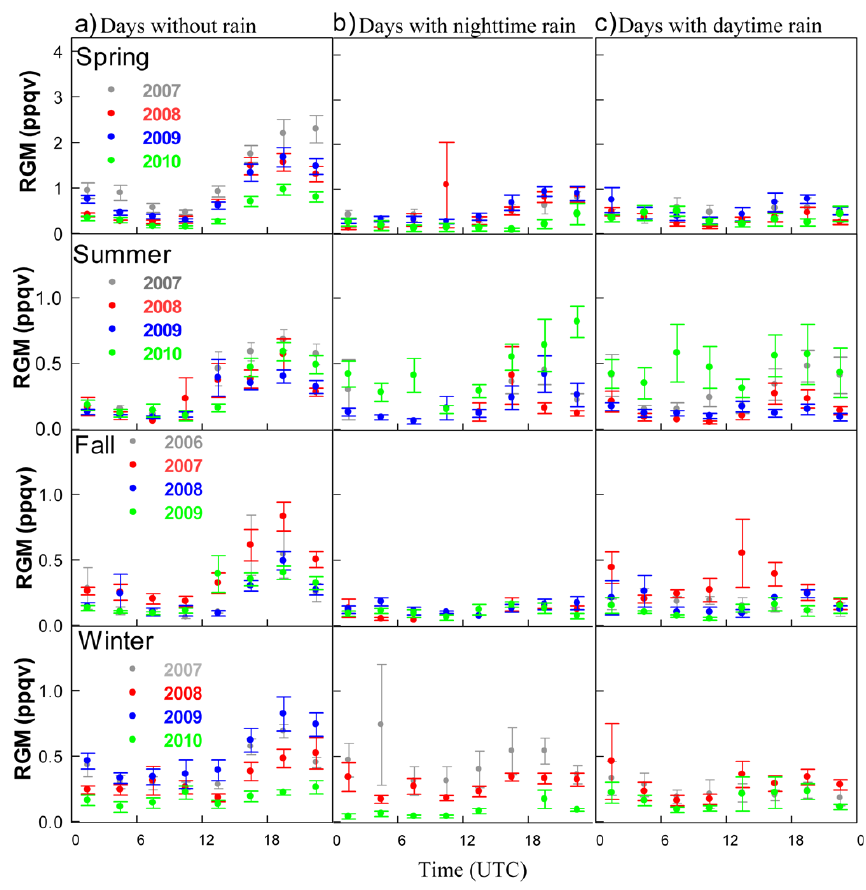
Fig. 15. Diurnal cycles of RGM at TF (coastal) averaged over days without rain (a) , days with nighttime rain (b) , and days with daytime rain (c) for all seasons during 2006–2010. It should be noted that there were data in February only in winter 2009 and there were too few data for conditions in (b) and (c) in winter to be presented for comparison. Similarly there were data in November only for fall 2006 and there were insufficient data in Fall 2006 for (b) . Precipitation in winter includes rain and snow. Local nighttime is about 00:00–11:00UTC, daytime 12:00–23:00UTC, and noontime is 16:00UTC during the Daylight Saving period of the year and 17:00UTC